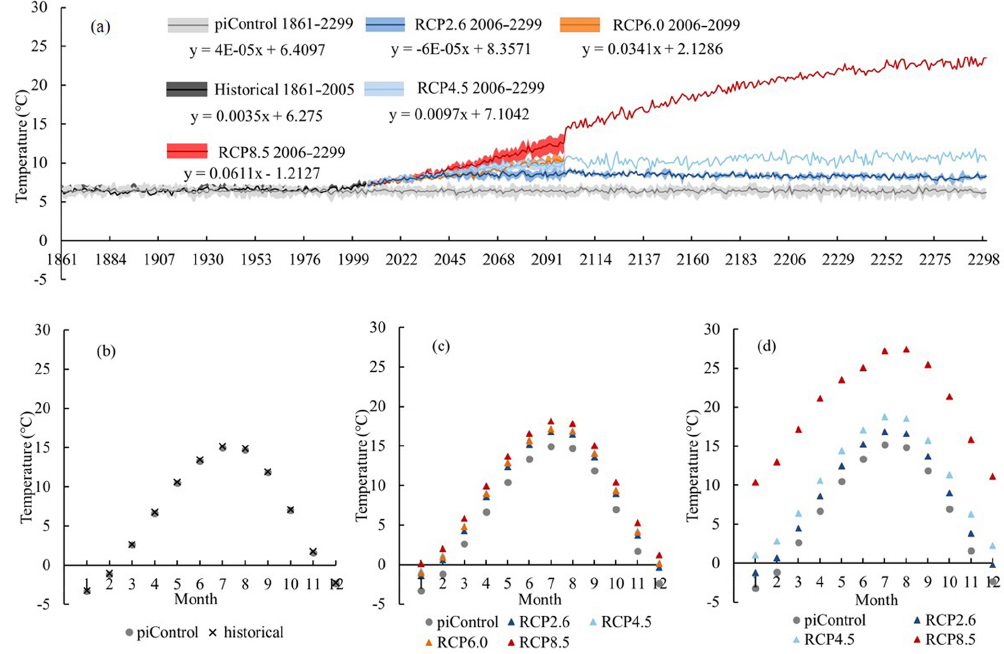
Figure 3. Inter-annual (a) and long-term averaged monthly dynamics (b–d) of the surface air temperature in the upper Yangtze River basin: comparison of the piControl scenario with the anthropogenic climate change scenarios (periods: a : 1861–2299; b : 1861–2005; c : 2006–2099; and d : 2100–2299). Table 5. Mean values of temperature, precipitation and simulated discharge in different